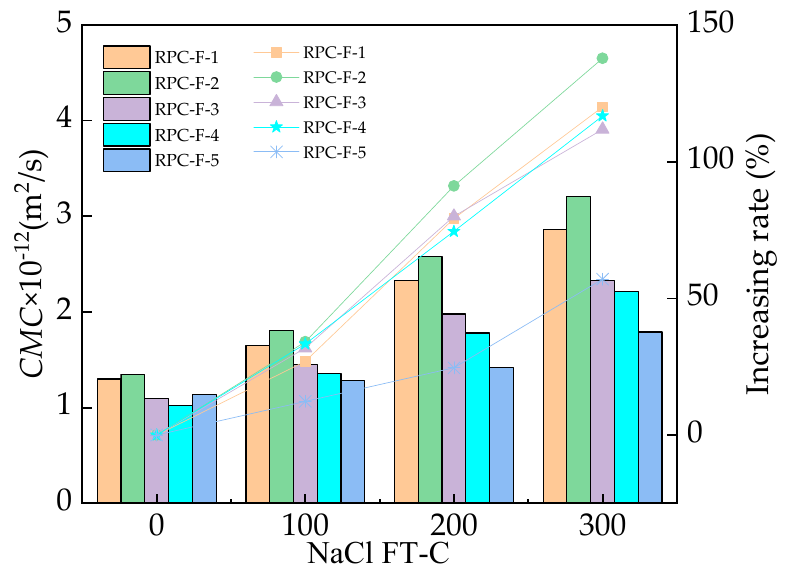
Figure 7. The CMC of RPC during NaCl FT-C.